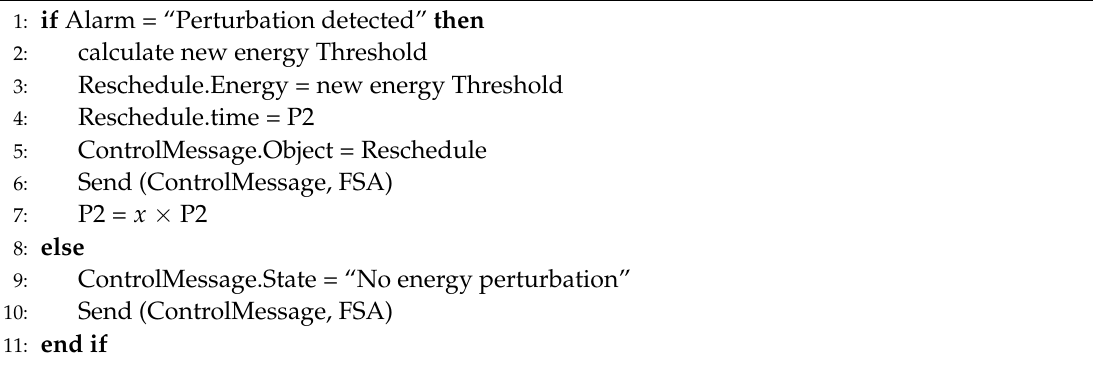
Algorithm 1 Pseudo code of energy scheduler agent (ESA) alarm triggering behaviour (Period